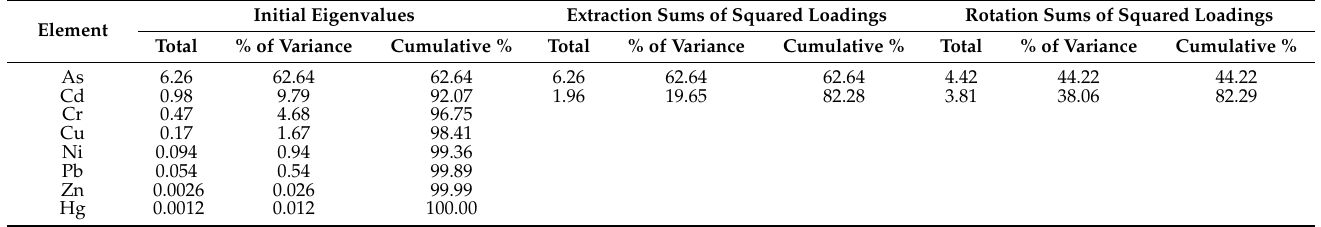
Table A2. Total Variance Explained.